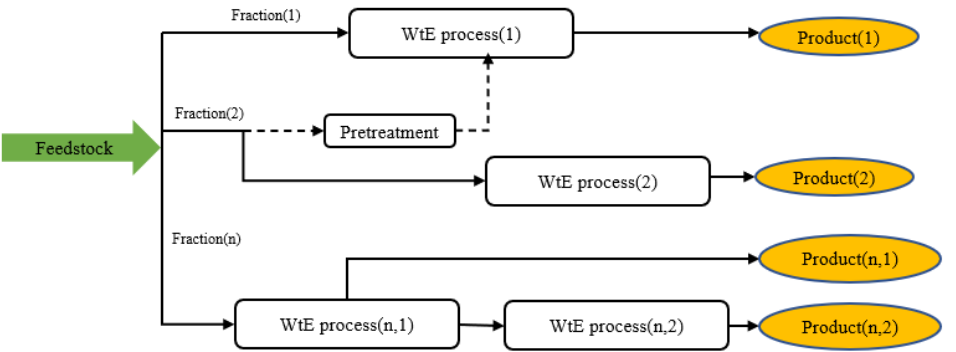
Figure 10. An illustration for biorefinery integration by conversion Figure 10 . An illustration for biorefinery integration by conversion process.